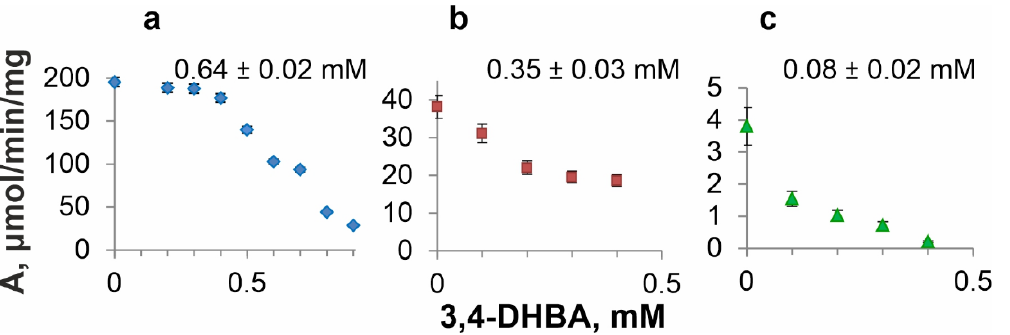
Figure 7. 3,4-DHBA inhibition profiles and half-maximal inhibitory constants of DSDs. ( a ) Qa-4, ( b ) QsuB, ( c ) AsbF. IC 50 values are noted on top of the graphs.